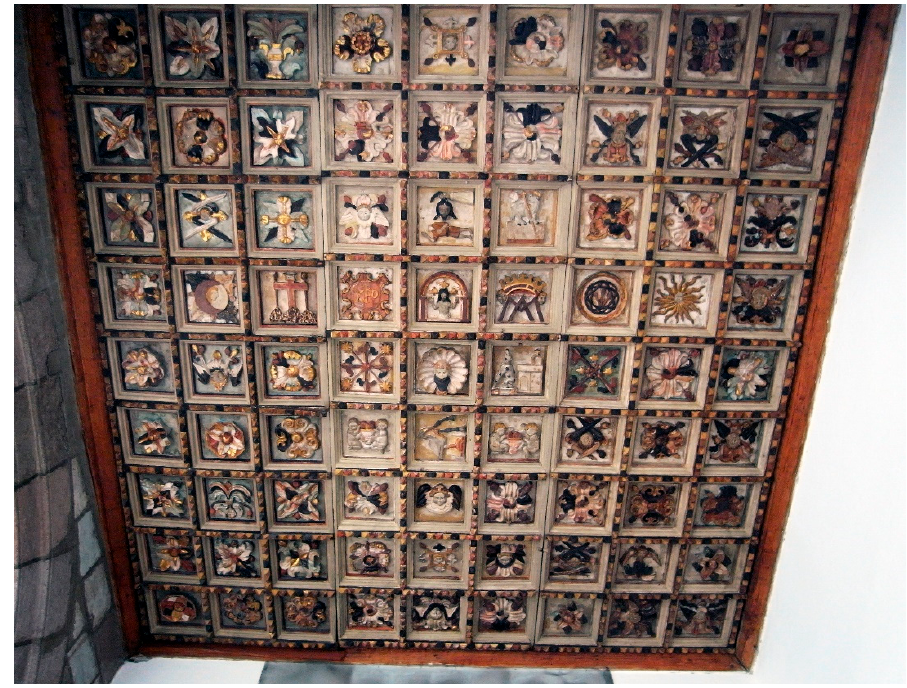
Figure 3. Cloister chapel’s ceiling of San Juan Bautista de Coyoacán convent. Mexico City. Photo took by